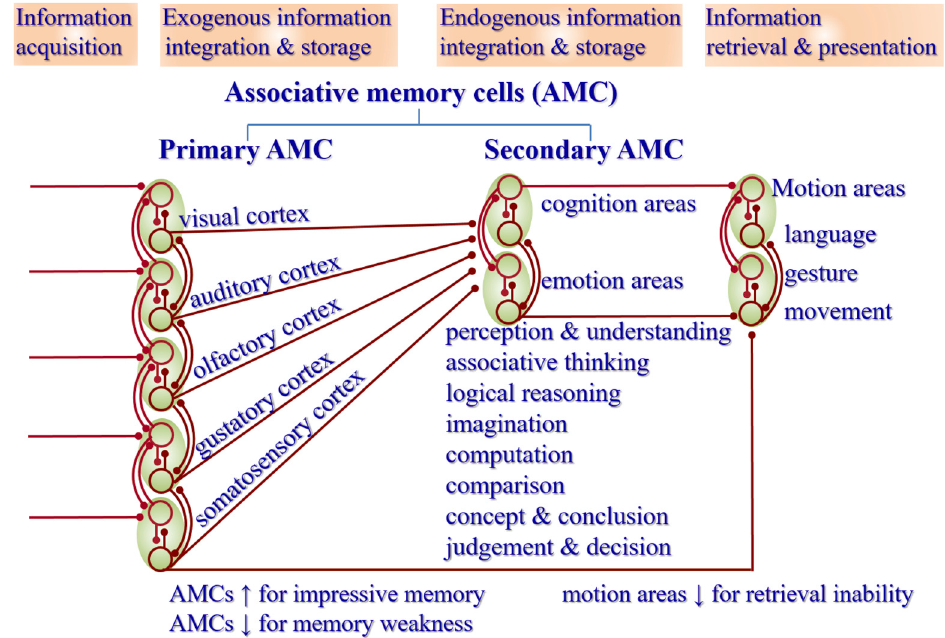
Figure 2. Associative memory cells and their roles in the memory, cognition and emotion. Associative learning and memory can be divided into four stages, i.e., information acquisition, exogenous information integration and storage, endogenous information integration and storage as well as information retrieval and presentation. Based on the sources of information integration and storage, associative memory cells (AMC) are classified into primary AMCs in sensory cortices to memorize exogenous information and secondary AMCs in cognition-, emotion- and behavior-related brain areas to memorize endogenous information during associated cognition and emotion events. Cross- modal associative memory cells are recruited by mutual innervations among sensory cortices or between cognition- and emotion-related brain areas. Intramodal associative memory cells are recruited by mutual innervations among neurons in a single-modality sensory cortex, cognition brain area or emotion brain area. The upregulations of the AMC number and active strength facilitate memory to be impressive, or vice versa. The functional downregulation of motion-related brain areas leads to the inability of memory retrieval and